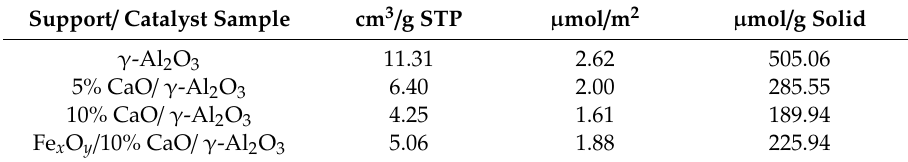
Table 2. NH 3 -TPD total acidity of the prepared catalyst and the catalyst